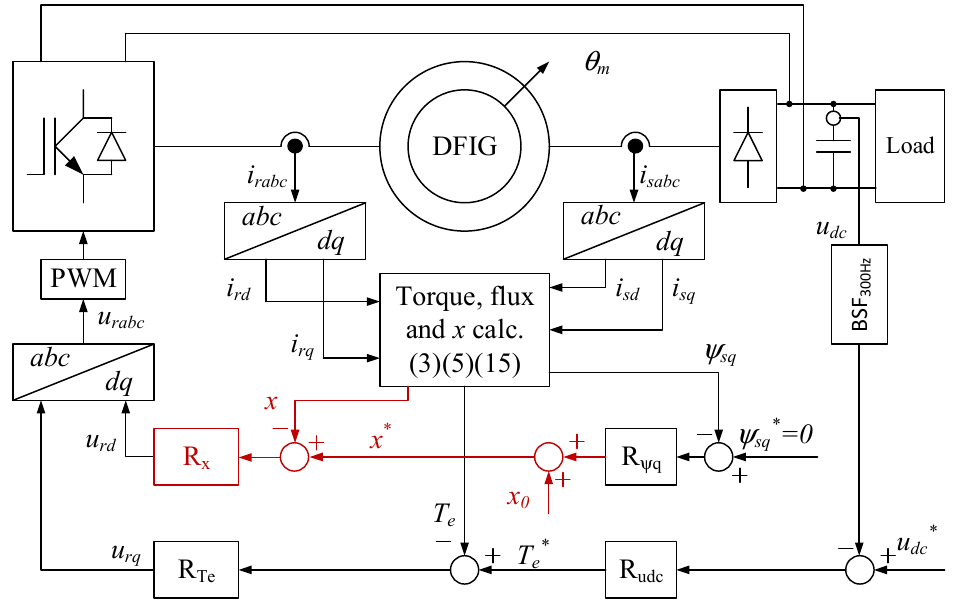
Figure 4. Stand-alone DFIG-DC voltage generator controlled with the direct torque and x variable control